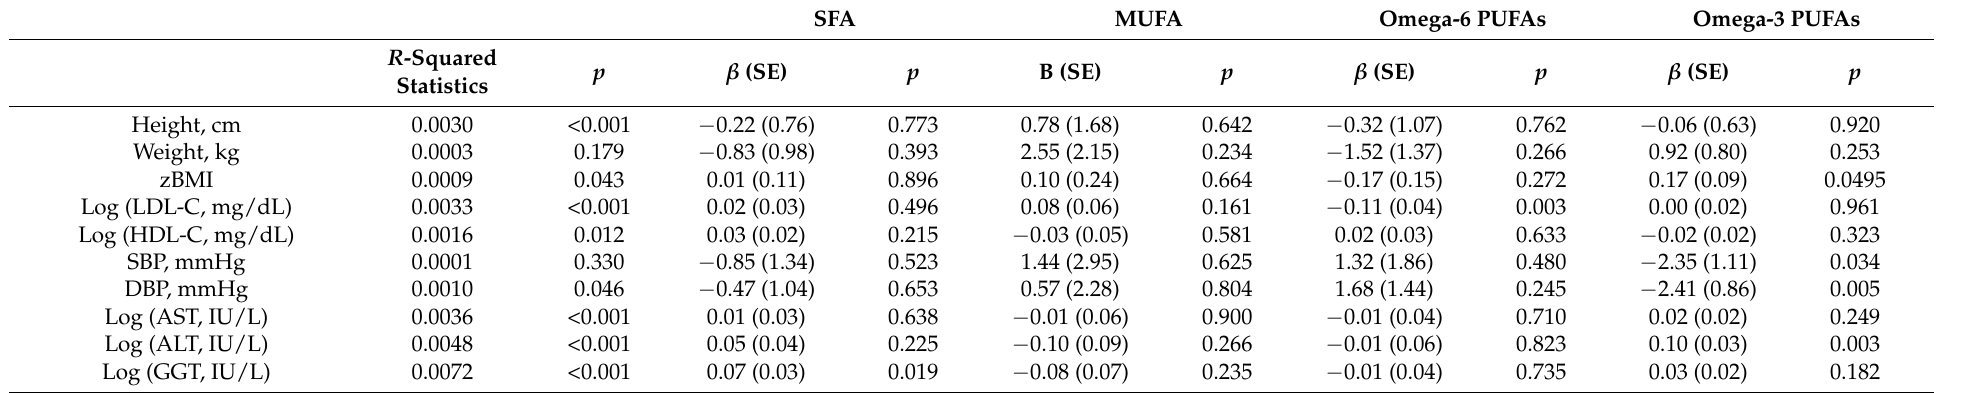
Table 3. Compositional regression